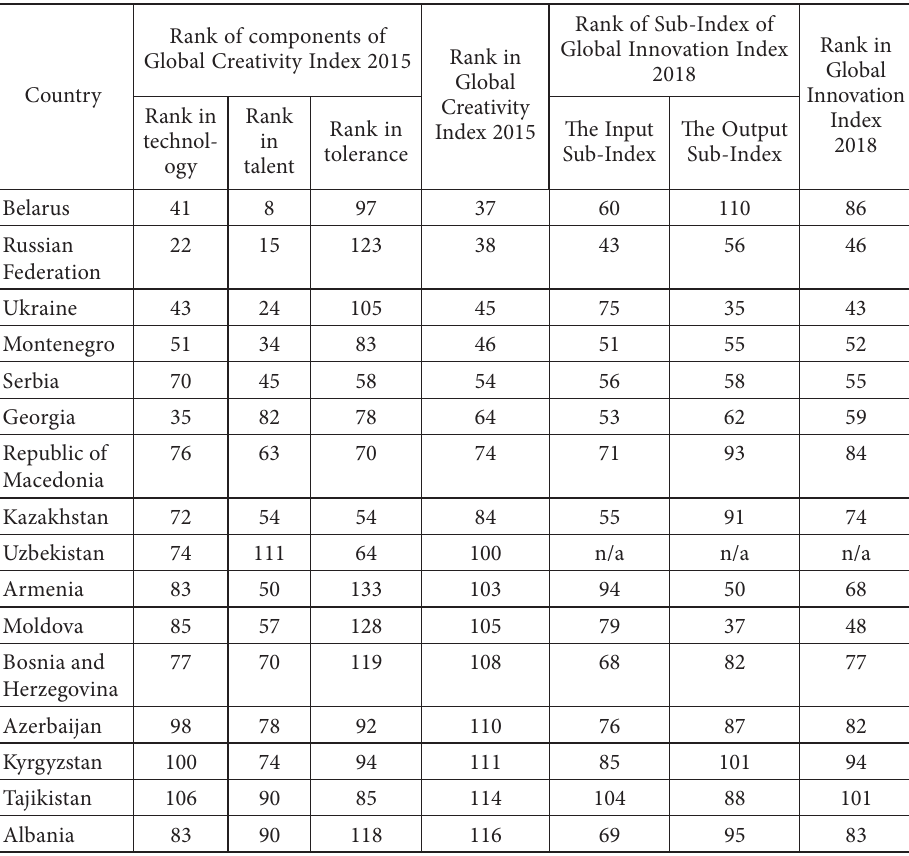
Table 2. Dynamics of indicators reflecting the potential for the development of creative industries in economies in transition (source: created by authors (based on Florida, Mellander, & King, 2015; Dutta, Lanvin, & Wunsch-Vincent,